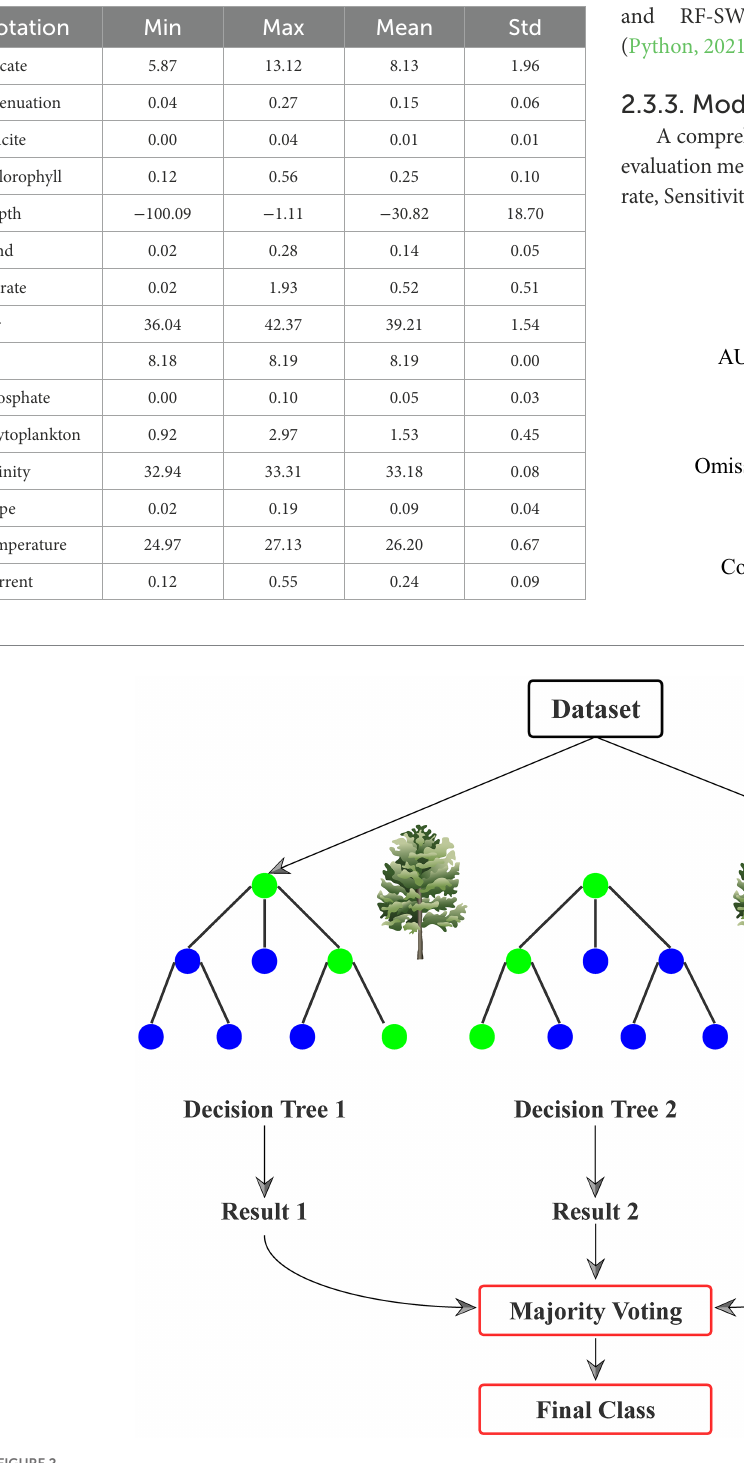
TABLE 2 Statistical analysis results for different environmental variables.